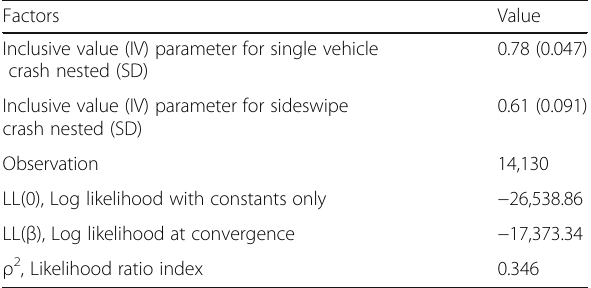
Table 2 Crash Types Estimation of Nested Logit Model